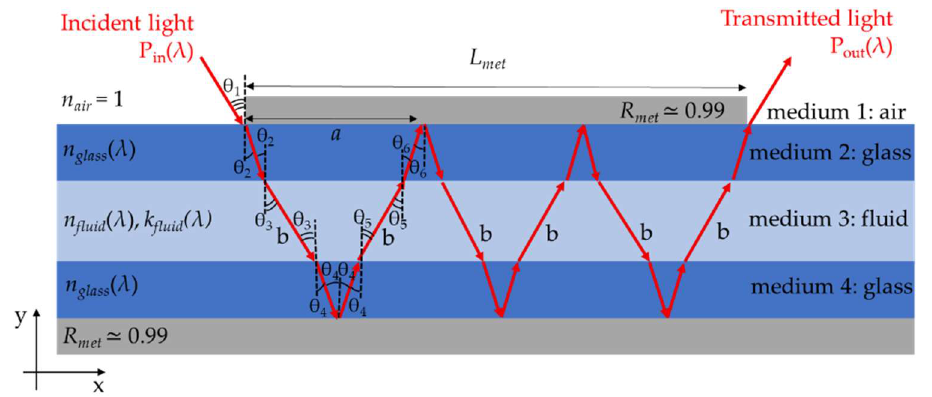
Figure 3. Schematic representation of the longitudinal sections of the rectangular glass capillary and light path travelled by light in case of N = 3. P in ( λ ) is the input optical power, P out ( λ ) is the output optical power.